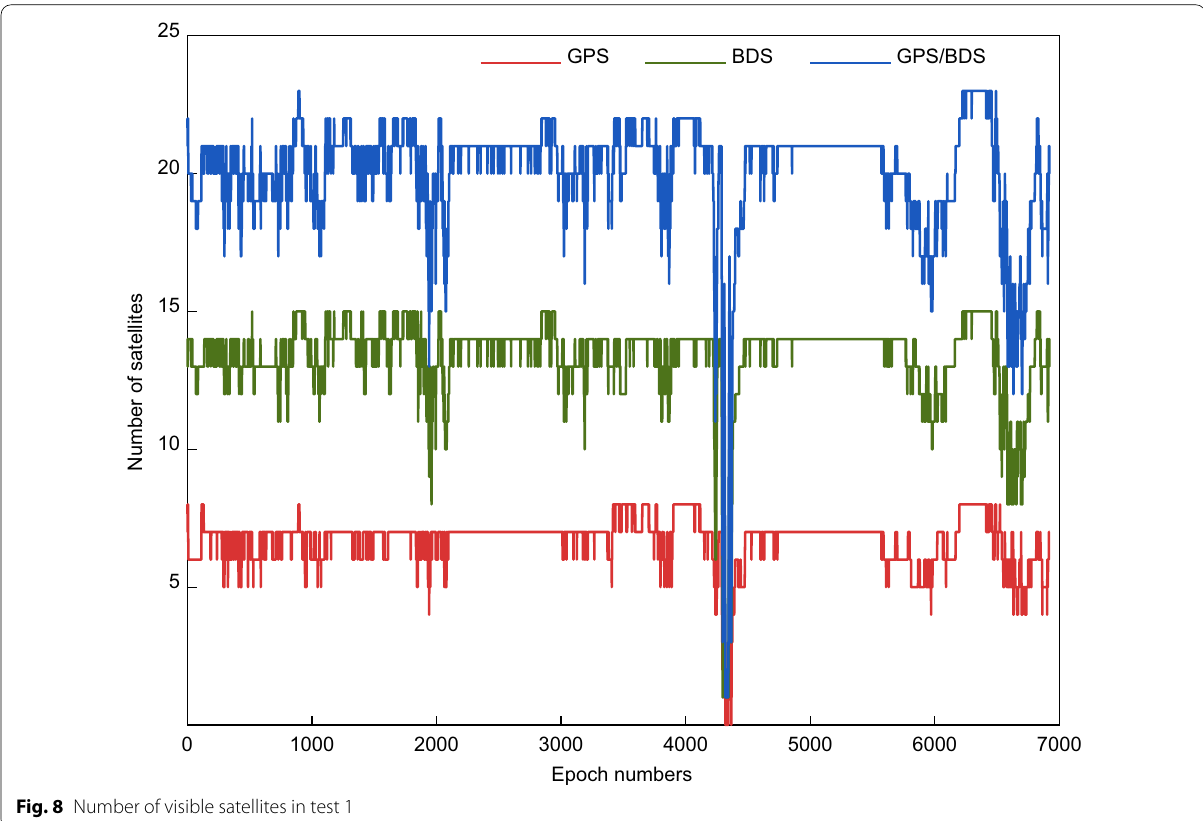
Fig. 8 Number of visible satellites in test 1